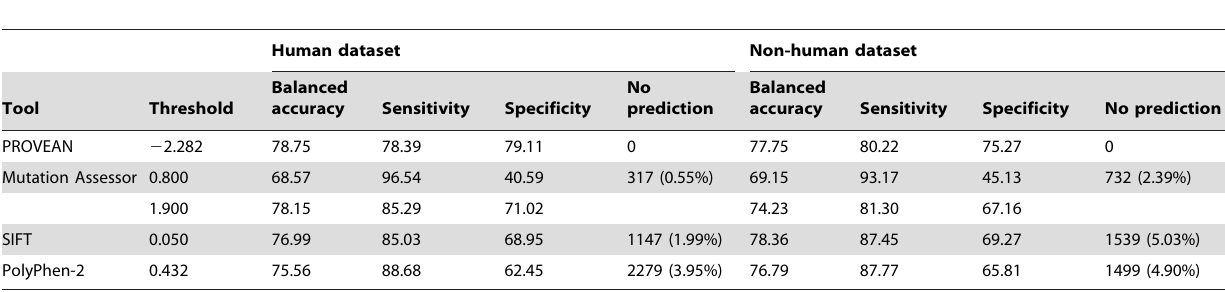
Table 5. Binary classification performance of four different tools for single amino acid substitutions in human and non-human proteins.